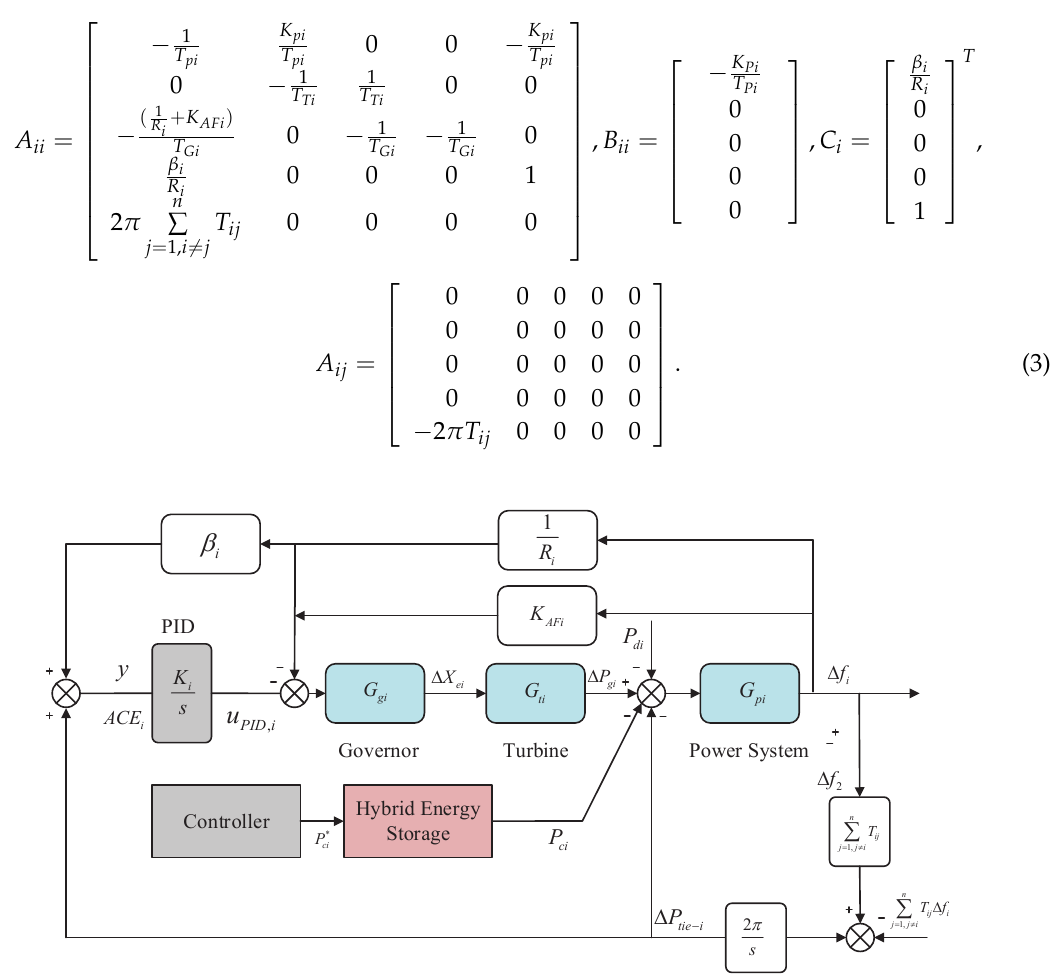
Figure 1. The i -th control area of load frequency control (LFC) in the multi-area interconnected power system